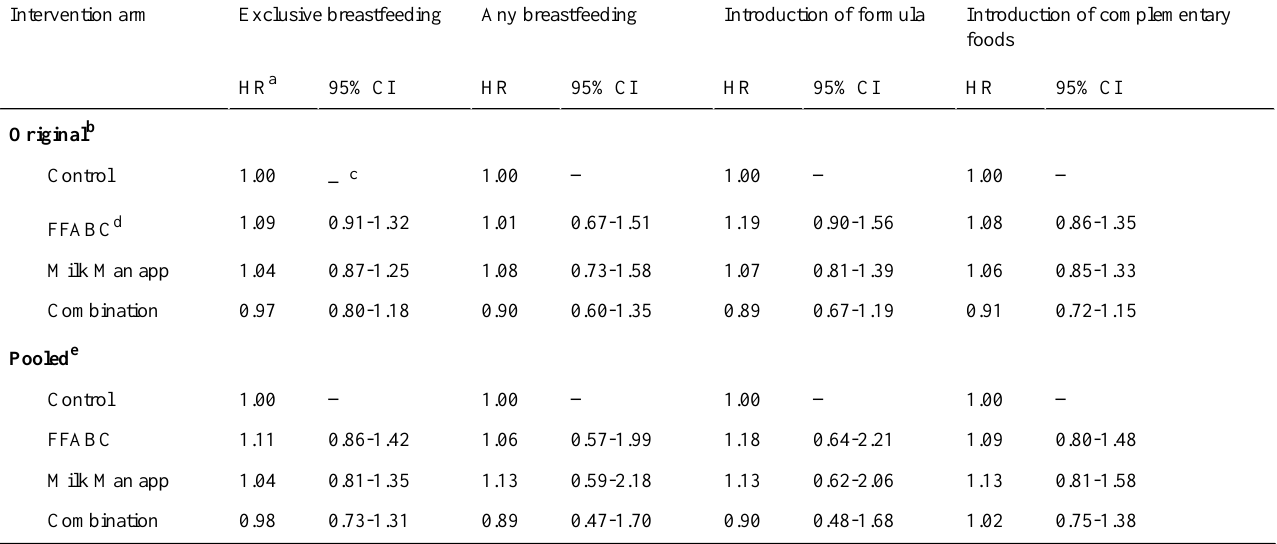
Table 2. Comparison between control and intervention groups of risk of cessation of exclusive and any breastfeeding and introduction of formula and solids before 26 weeks: intention-to-treat